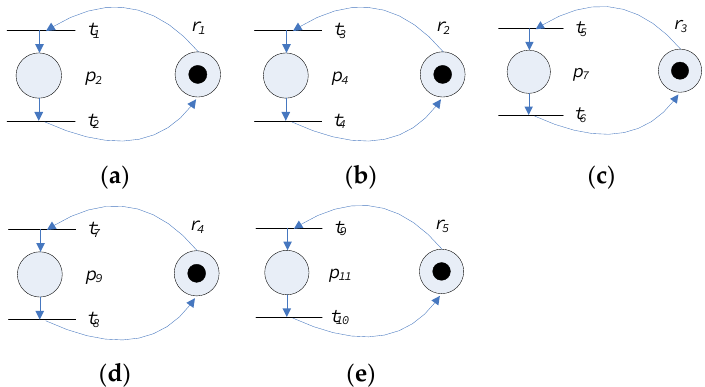
Figure 8. ( a ) A discrete timed Petri nets (DTPN) model for resource agent R 1; ( b ) A DTPN model for resource agent R 2; ( c ) A DTPN model for resource agent R 3; ( d ) A DTPN model for resource agent R 4; ( e ) A DTPN model for resource agent R 5.